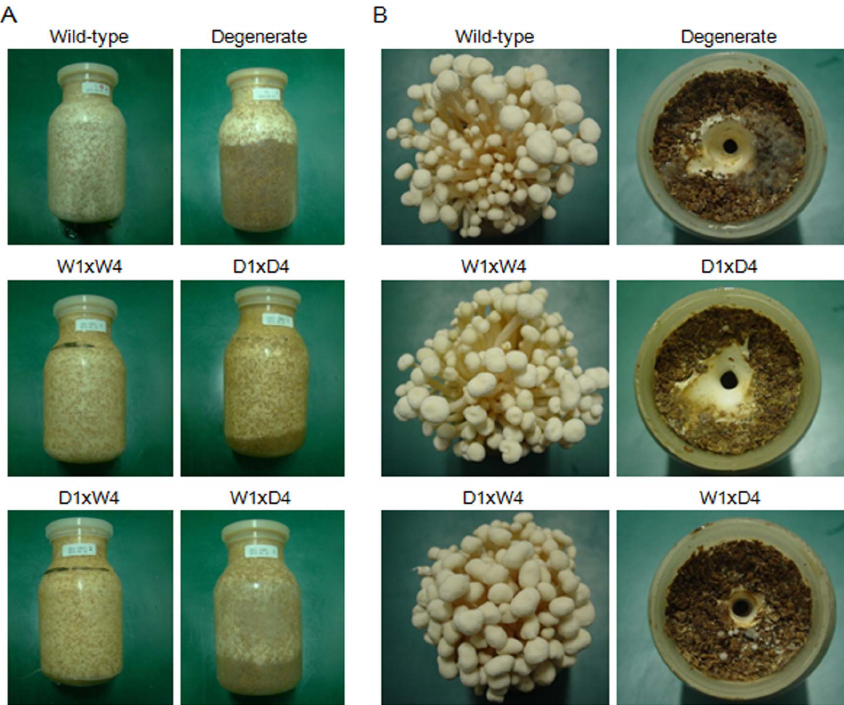
Figure 3. Mycelial running and formation of fruiting bodies. (A) Mycelial running of the wild-type and degenerate dikaryons and the hybrids of crosses between monokaryons of the wild-type (Fv1-5) and degenerate (Fv1-5 d ) strains grown on sawdust medium in bottle cultures for 35 d at 20 u C after inoculation. (B) Morphologies of the fruiting bodies produced by the strains represented in the left panel. The experiments were performed using triplicate samples.